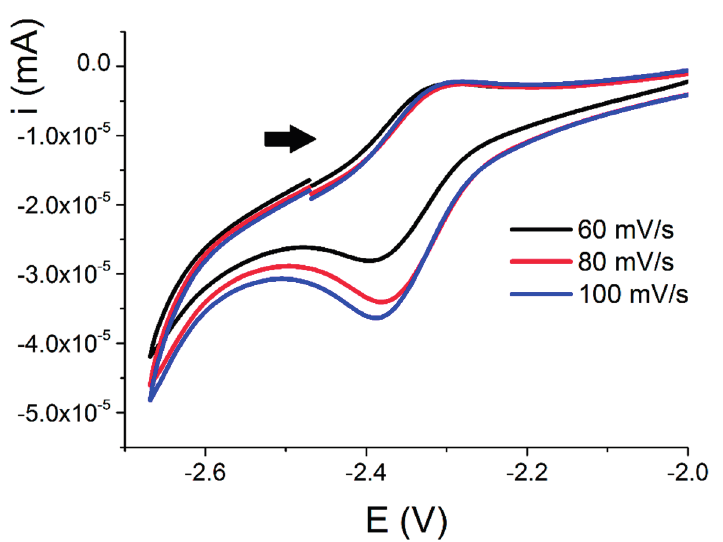
Figure 4. Cyclic voltammogram of 2 (0.5 mM in THF, 0.1 M [NBu n 4 ][BF 4 ]). Black arrow shows the direction of applied potential from the